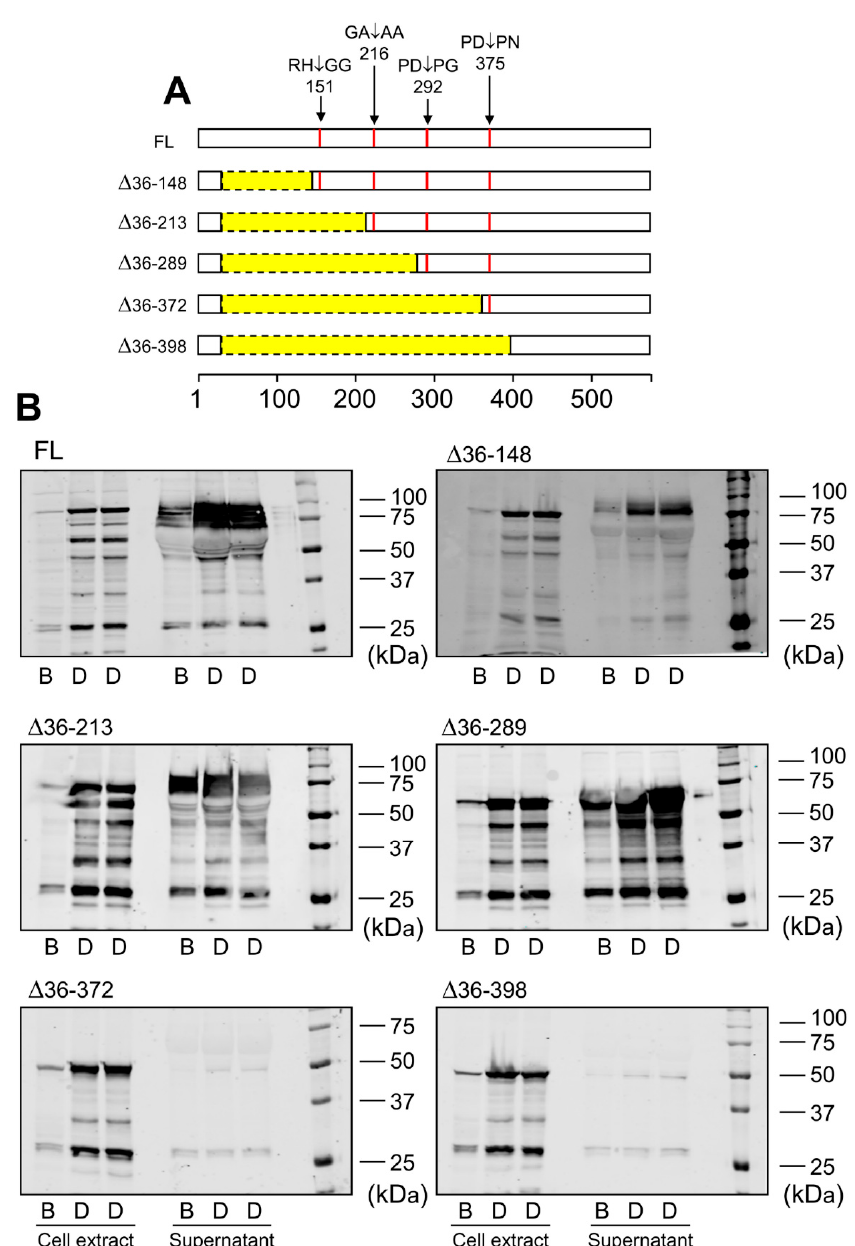
Figure 4. Expression of LOXL1 truncated forms of LOXL1-GFP protein. ( A ) Schematical represen- tation of truncated forms of LOXL1-GFP protein within the LOXL1 sequence (deletions marked in yellow) showing the position of the cleavage sites in red. The set of constructs include decreasing portions of the N-terminal end of LOXL1 protein but keep the signal peptide for proper transit through Golgi and secretion. ( B ) Western blotting analysis of the expression of the full-length (FL) and indicated truncated forms of LOXL1 protein as assessed with the anti-GFP antibody under basal conditions ( B ) and upon stimulation with doxycycline (D) in cell extracts and supernatants. Note that all of the constructs gave rise to the corresponding intracellular LOXL1-GFP form as detected in the cell-extract fractions. However, analysis in the cell supernatants revealed that the more C-terminal truncated forms, ∆ 36–372 and ∆ 36–398 failed to appear as extracellular secreted proteins. The blots shown correspond to representative experiments performed twice with two independent